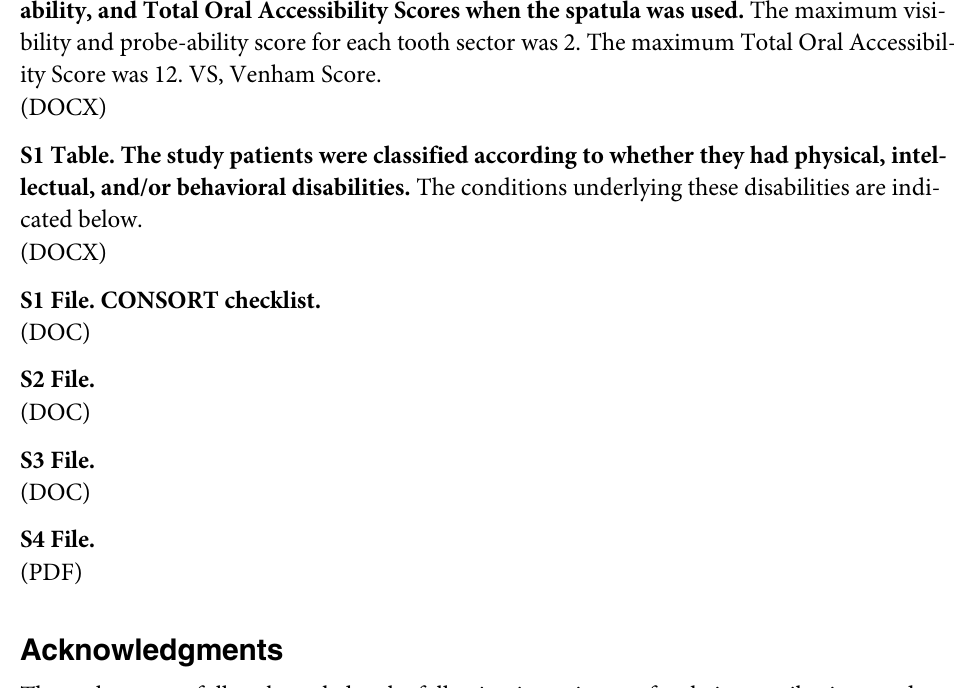
S1 Fig. Relationship between Venham Score at inclusion and change in visibility, probe- ability, and Total Oral Accessibility Scores when the spatula was used. The maximum visi- bility and probe-ability score for each tooth sector was 2. The maximum Total Oral Accessibil- ity Score was 12. VS, Venham Score. S1 Table. The study patients were classified according to whether they had physical, intel- lectual, and/or behavioral disabilities. The conditions underlying these disabilities are indi- cated